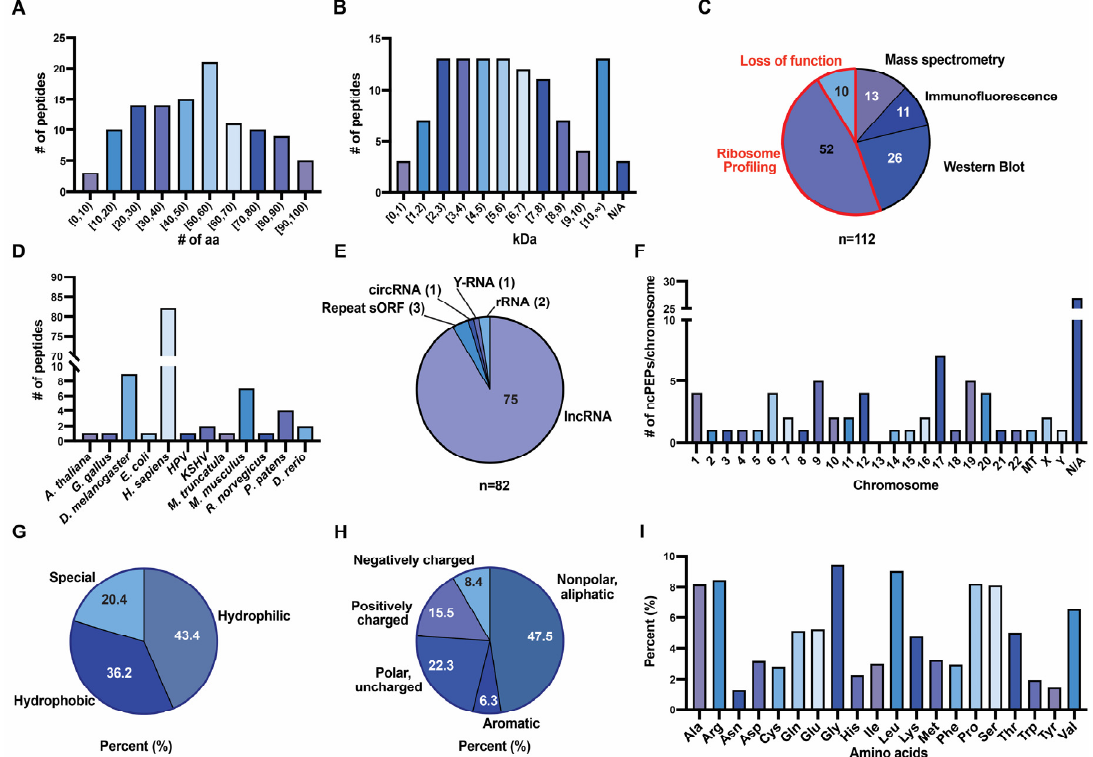
Figure 3. Characteristics of ncPEPs from the FuncPEP database. ( A ) NcPEP´s length in amino acids; ( B ) NcPEP´s molecular weight (kDa); ( C ) Methods used to detect ncPEPs (red border and font—